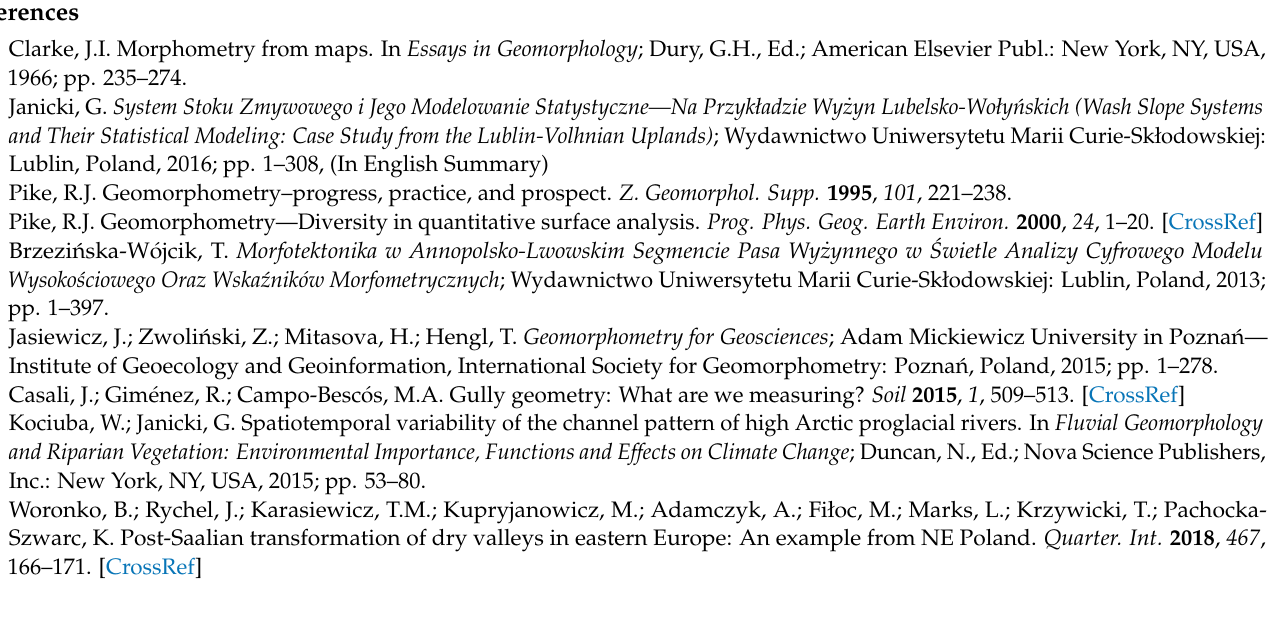
User Guide; Figure S1: Location of the headwater depressions in the study area after Mazurek [88].; Table S1: Geometric parameters of the headwater depressions.; Table S2: Hypsometric parameters of the headwater depressions.; Figure S2: An example of a visualisation of the output data (Popielewo 4 test site) of the Hypsometry module: (a) DEM map; (b) Slope map; (c) Aspect map; (d) TRI map; (e) TWI map; (f) Hypsometric curve graph.; Figure S3: Variation in maximum, mean, and minimum of the selected morphometric parameters for 1 m, 2 m, 3 m, 5 m, 10 m LiDAR DEM (based on the medium size valleys): (a) Zmean parameter; (b) Zrange parameter; (c) Smean parameter; (d) Amean parameter; (e) TRImean parameter; (f) TWImean parameter; (g) HI parameter; (h) V parameter.; Figure S4: Variation in maximum, mean, and minimum of the selected morphometric parameters for 1 m, 2 m, 3 m, 5 m, 10 m LiDAR DEM (based on the small size valleys): (a) Zmean parameter; (b) Zrange parameter; (c) Smean parameter; (d) Amean parameter; (e) TRImean parameter; (f) TWImean parameter; (g) HI parameter; (h) V